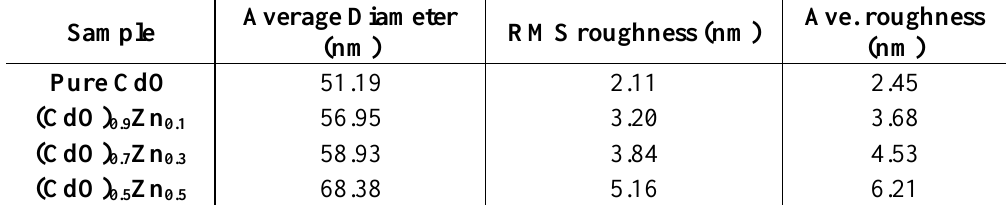
Zn thin films. 1-x x